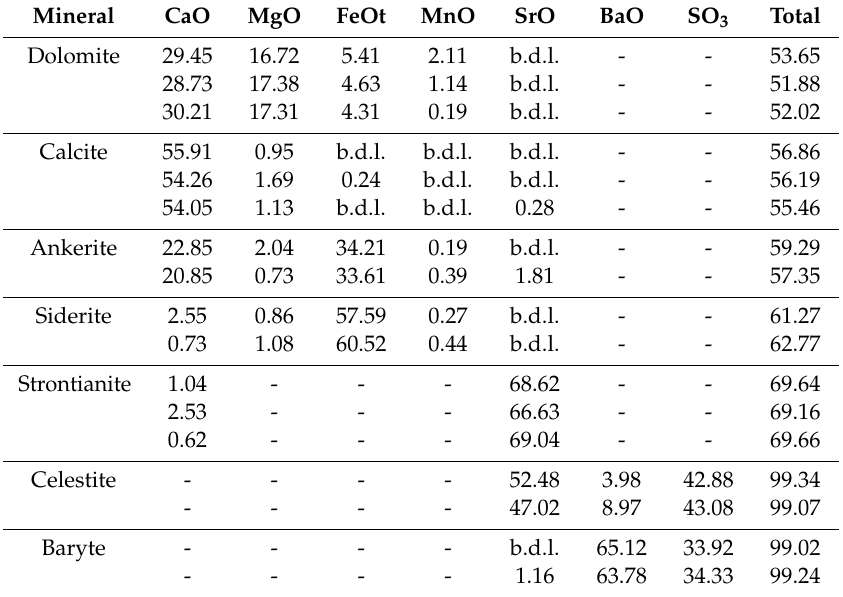
Table 1. The mineral composition of Ca–Mg–Fe–carbonates and Ba–Sr–sulphates of the Petyayan-Vara “ancylite ores”, “bastnäsite ores”, and hybrid rocks. Representative analyses (wt.%).